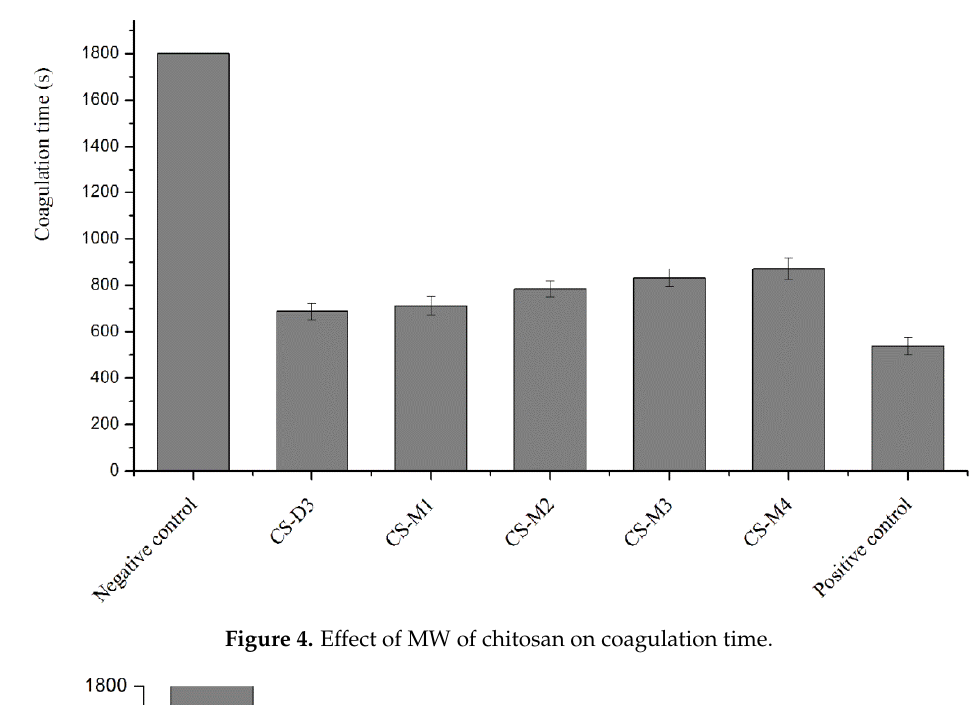
Figure 4. Effect of MW of chitosan on coagulation time.